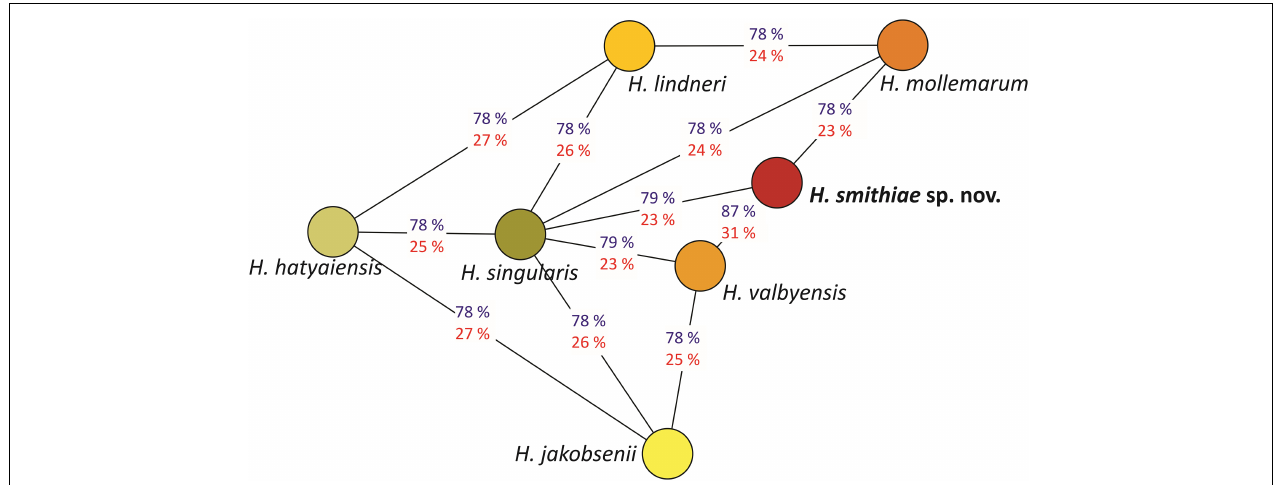
FIGURE 3 | Genomic relationships between species closely related to Hanseniaspora smithiae sp. nov., based on the average nucleotide identity (ANI; blue) and the digital DNA-DNA homology values (red). The network was inferred using the minimum spanning tree algorithm on the ANI values.